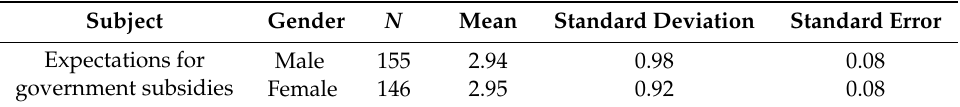
Table 8. Description of different